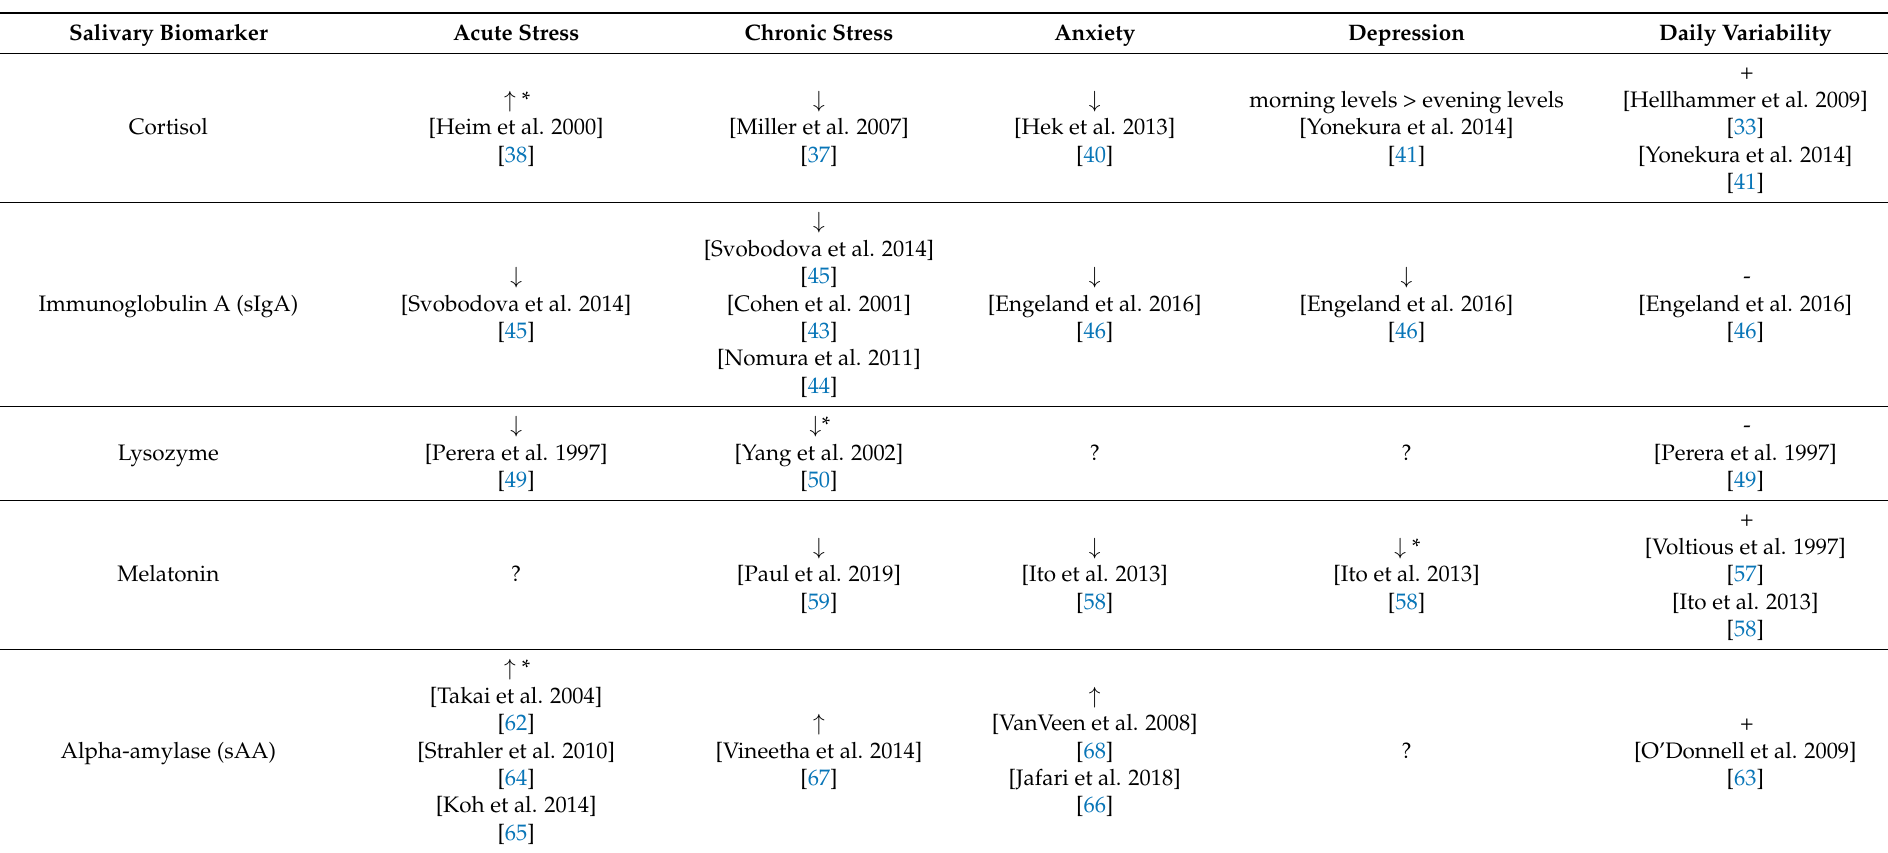
Table 1. The salivary biomarkers of stress, anxiety and depression and their daily variability. ↑ —increased concentration/activity, ↓ —decrease concentration/activity, ?—inconclusive or no results, *—scientifically proved/the most probable